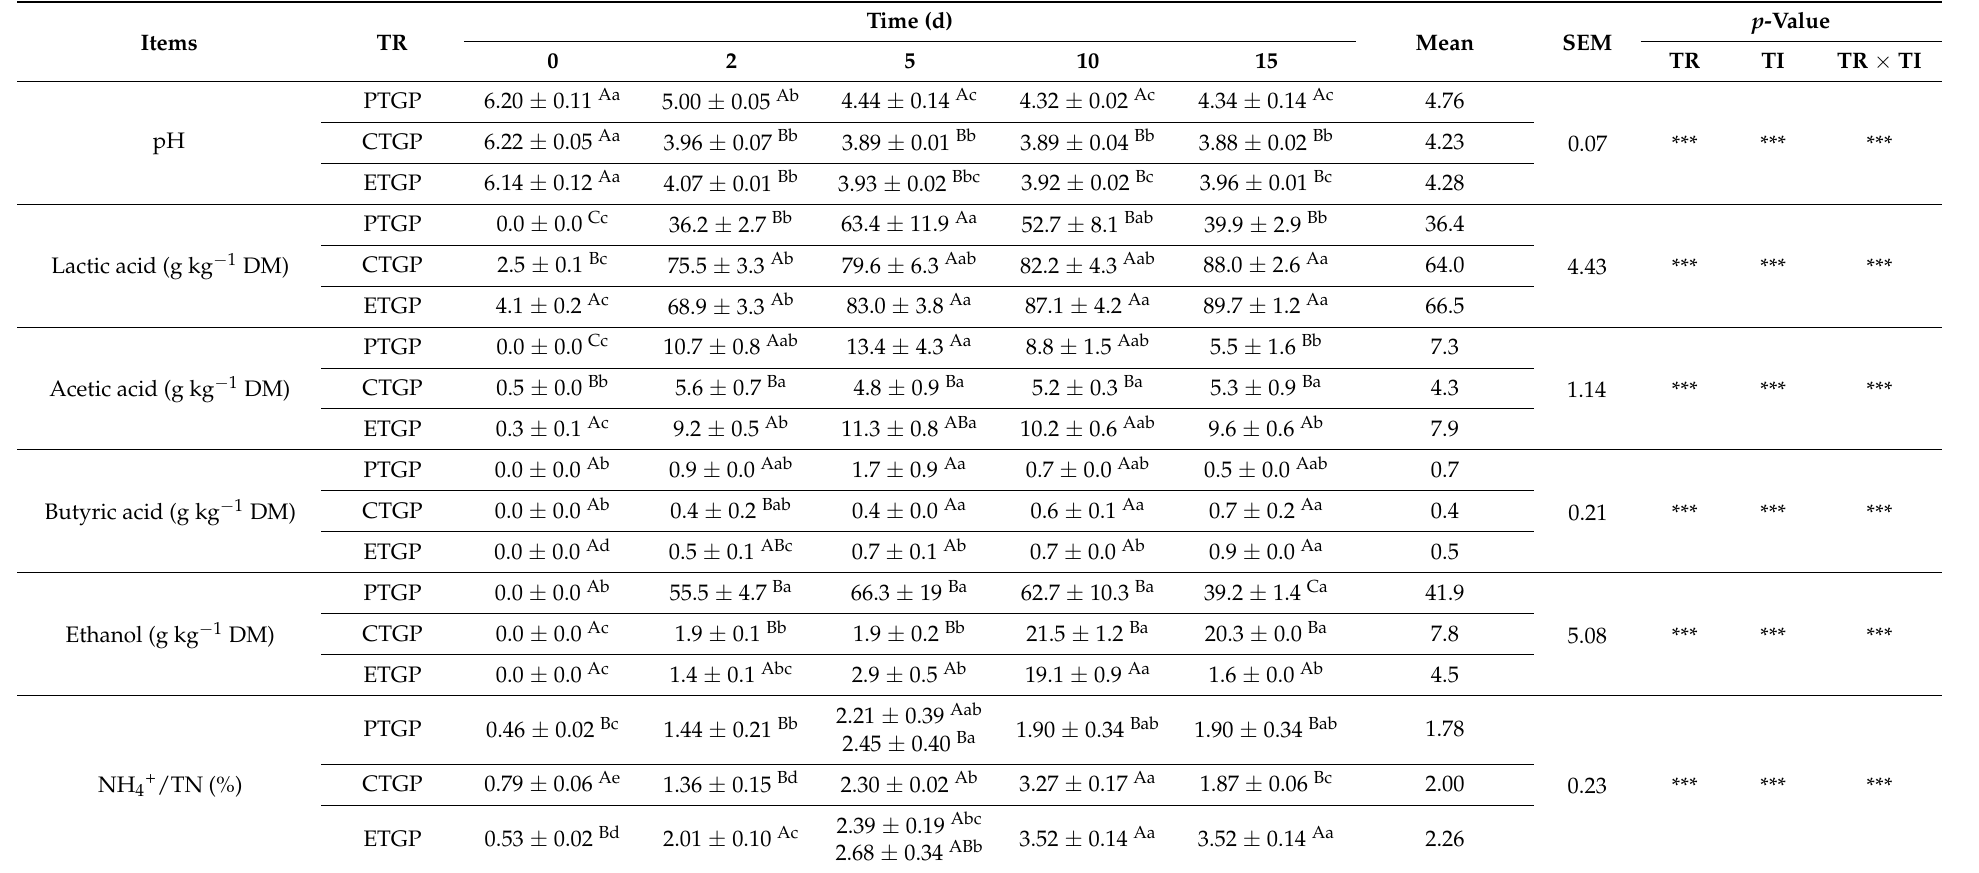
Table 4. Effect of exogenous additives and fermentation time on fermentation